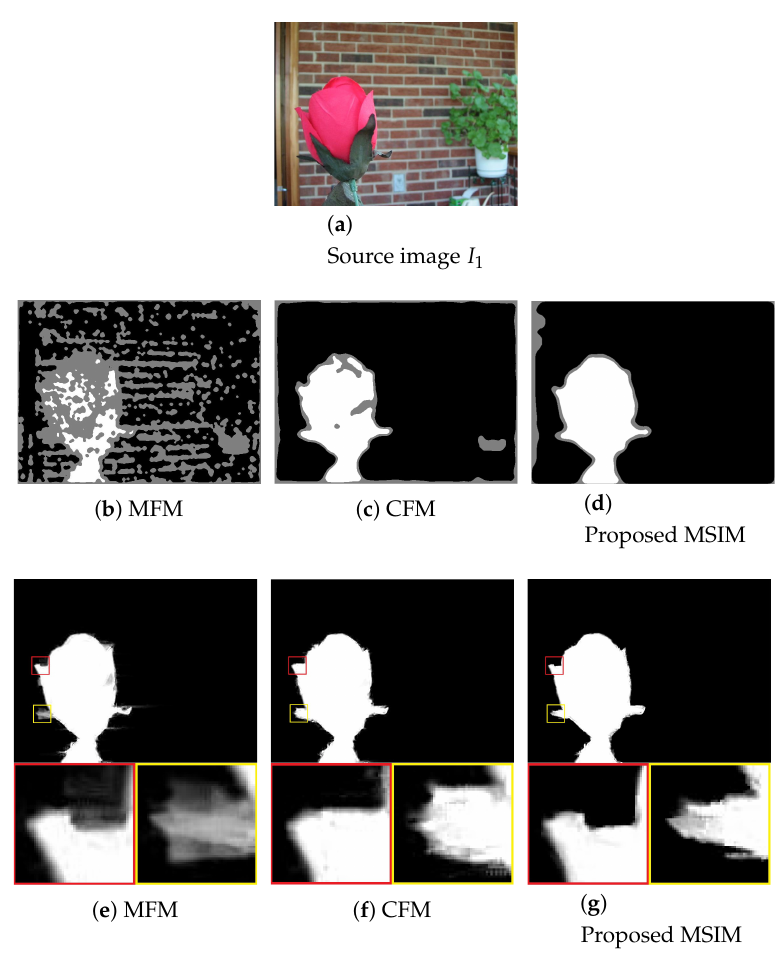
Figure 3. Results of Trimap and Alpha matte on flower image ( b – d ) trimaps of ( a ), ( e – g ) alpha mattes of Figure